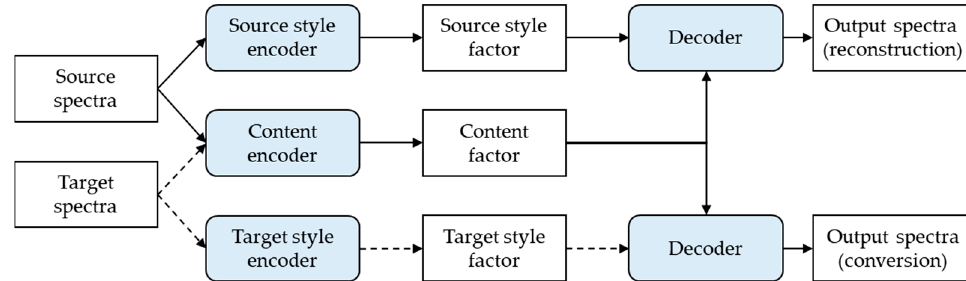
Figure 6. Flow of the proposed variational autoencoder (VAE)-based nonparallel speech conversion method. Each of the decoder networks are shared. The arrows indicate flow of the proposed method related to the source spectra or common elements (e.g., source style factor, content factor), and the dashed arrows indicate the flow of the method belonging to the target spectra (e.g., target spectra, target style factor).